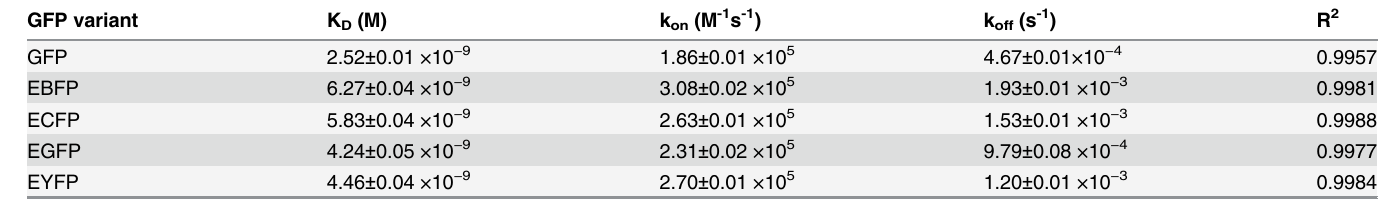
Table 1. Kinetic constants of Nanofitin D8 directed toward GFP variants.